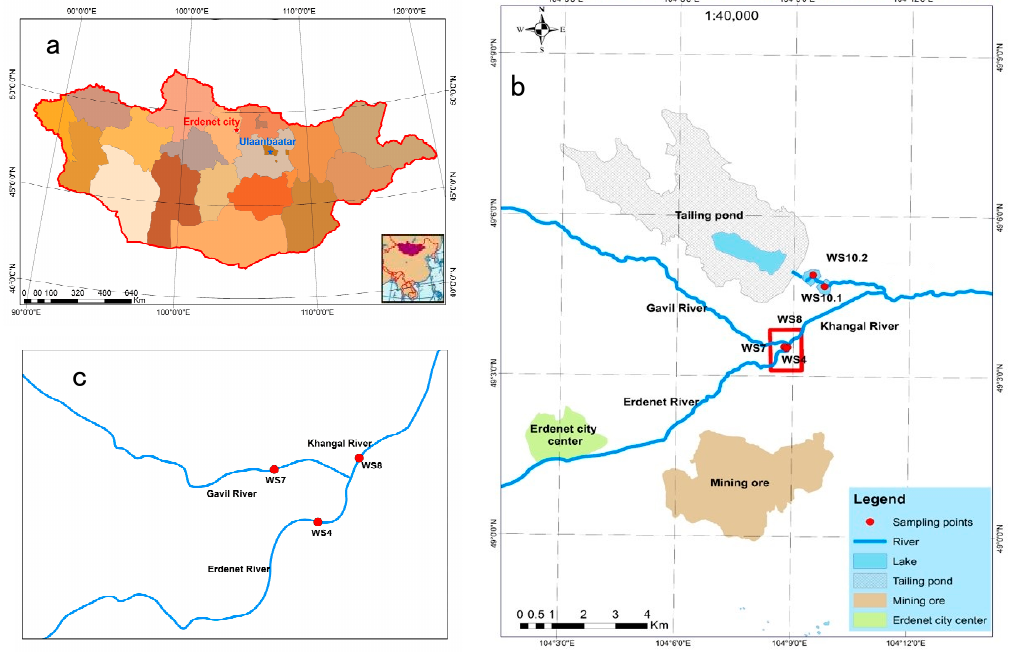
Figure 1. Study area with sampling locations: ( a ) Erdenet mine in Mongolia, ( b ) Erdenet mining area with sampling locations, and ( c ) the junction of the three rivers with sampling locations.